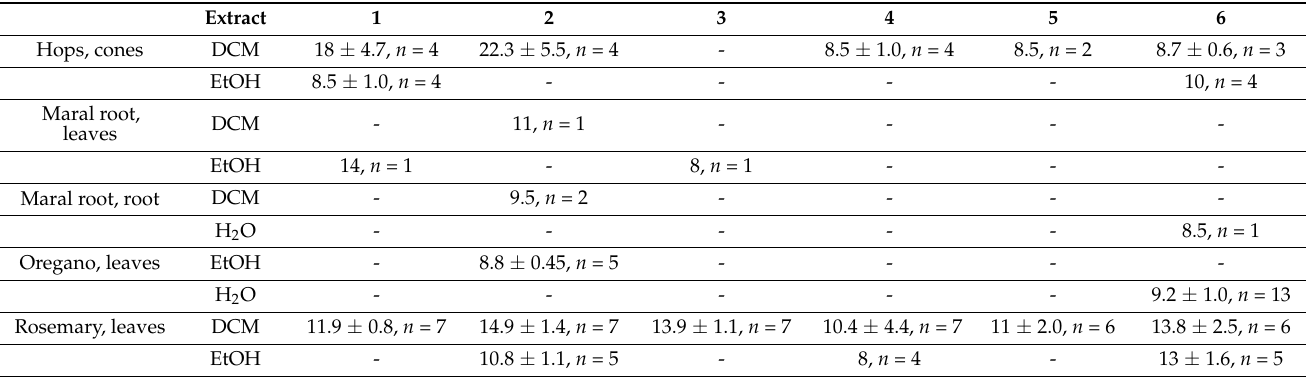
Table 5. Disk diffusion antimicrobial activity of herb extracts made in sequential order; DCM followed by EtOH and finally H 2 O. Bacterial species were grown on Mueller Hinton agar (MH), Marine agar (MA) and Luria Bertani agar (LB). Bacteria and growth medium used: 1. Staphylococcus aureus on